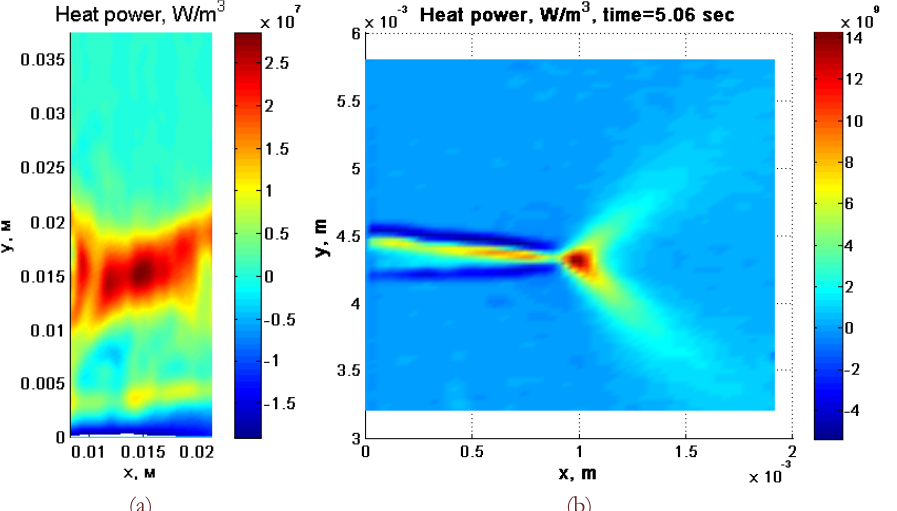
Figure 4: Experimental data for the heat power field near the crack tip at the beginning of unstable crack